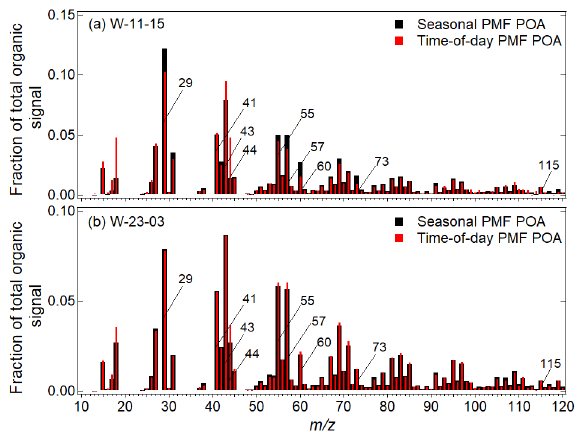
Figure 7. Mass spectra of time-of-day PMF POA and seasonal PMF POA for the periods (a) midday and (b) nighttime in winter 2017. Midday MS show larger differences compared to nighttime MS.